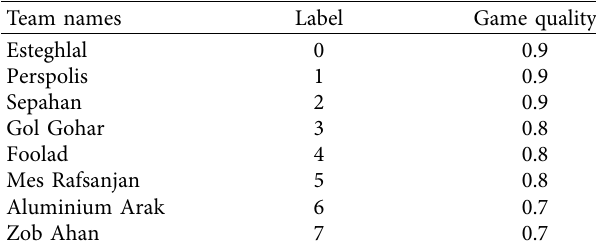
Figure 6: CFG. Table 4: Ranking of the country’s football clubs.